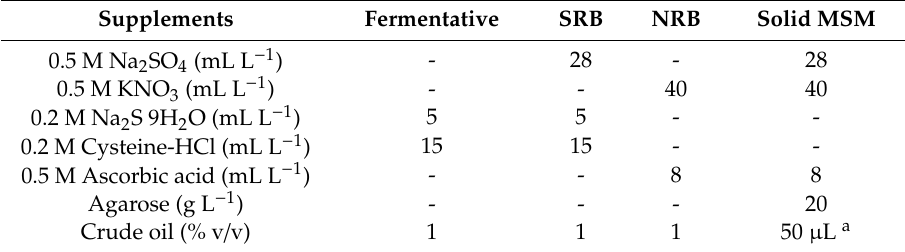
Figure 1. Workflow of the experimental setup for isolation of facultative anaerobic hydrocarbonoclastic biosurfactant-producing bacteria isolated from subaquatic sediments. All steps were carried out at 25 °C. Table 2. Selective supplements to mineral salts medium